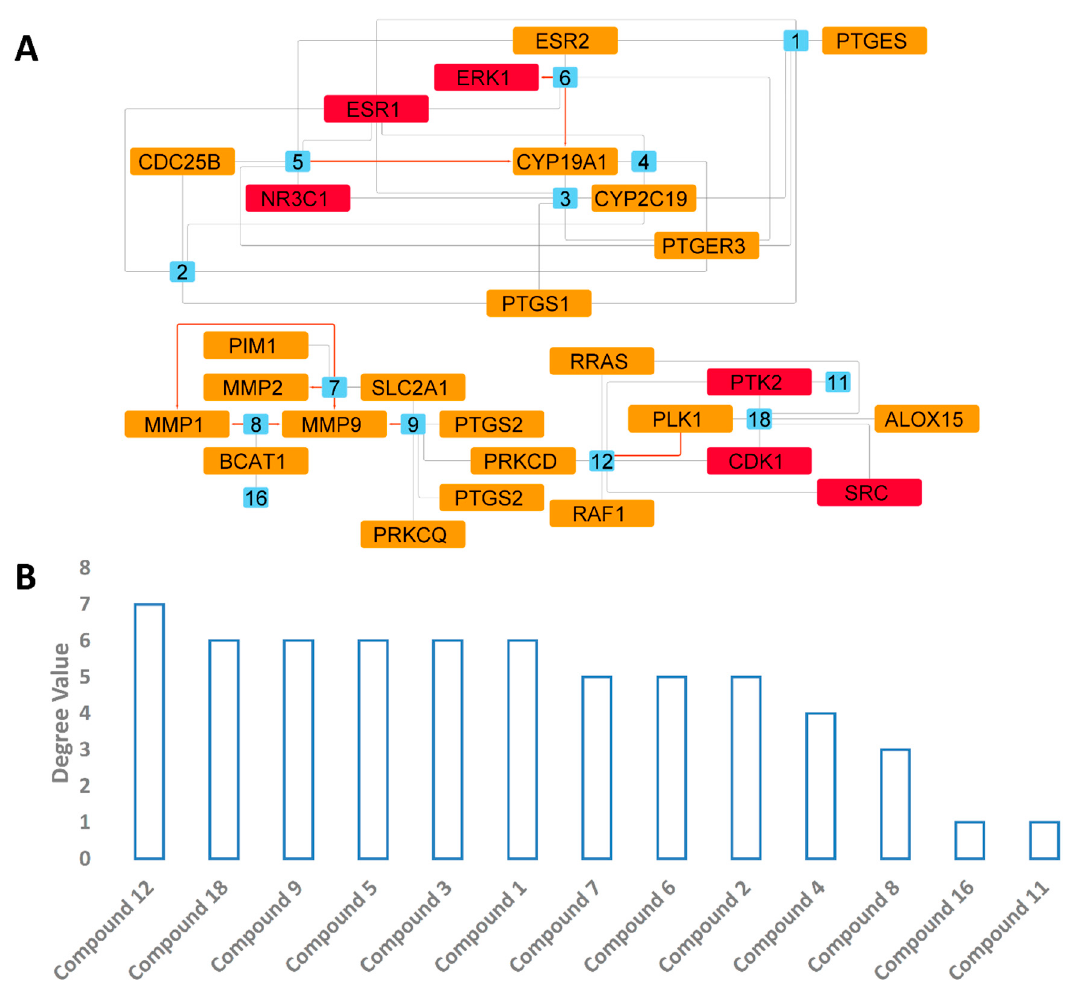
Figure 14. Compound-protein network. ( A ) This network consists of 39 nodes and 98 edges with average node degree of 4.23. Blue numbered nodes represent CE-derived compounds, and orange nodes represent BC-related proteins. Red nodes are hub proteins in the BC PPI network. ( B ) Degree values of the interacting compounds. Red-colored edges indicate MDS-validated interactions.